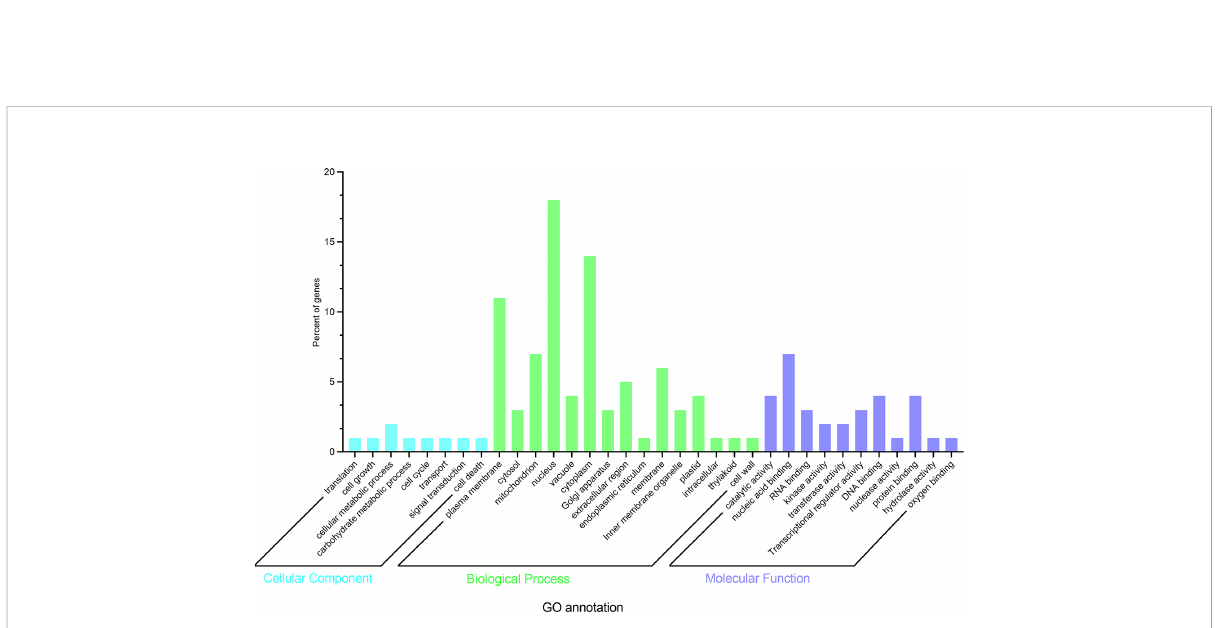
FIGURE 8 Functional categories of the genes in 100kb fl anking regions around peak SNPs.